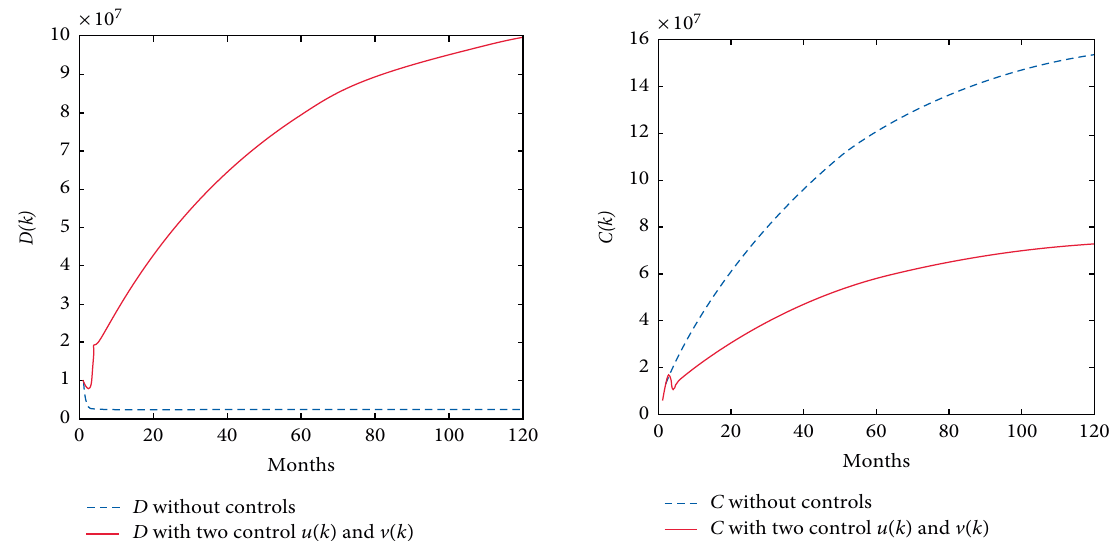
Figure 4: The evolution of the number of diabetics with and without complications with two controls 𝑢